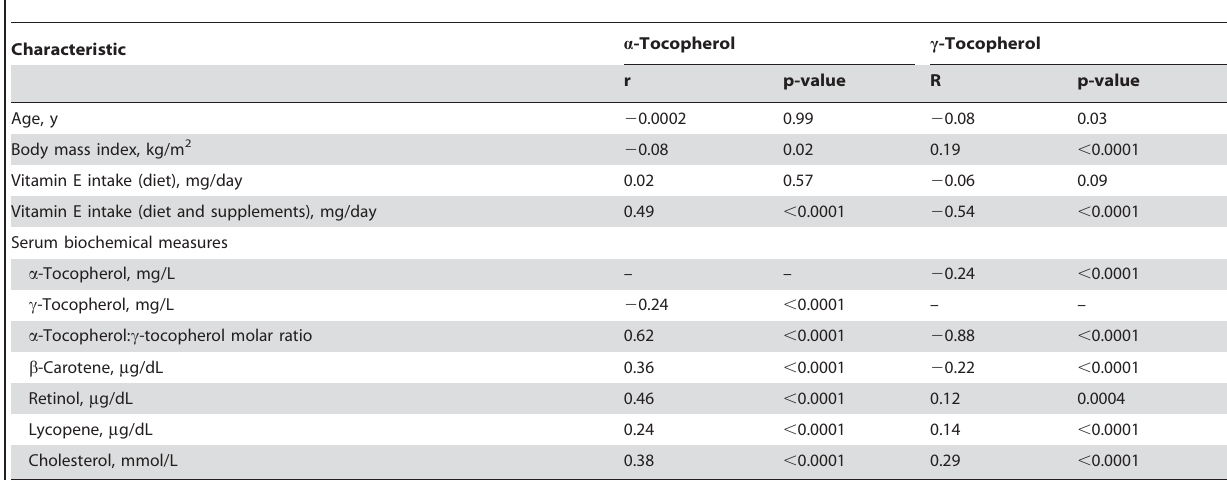
Table 2. Correlations between baseline characteristics and a -tocopherol and c -tocopherol among controls, PLCO Study.